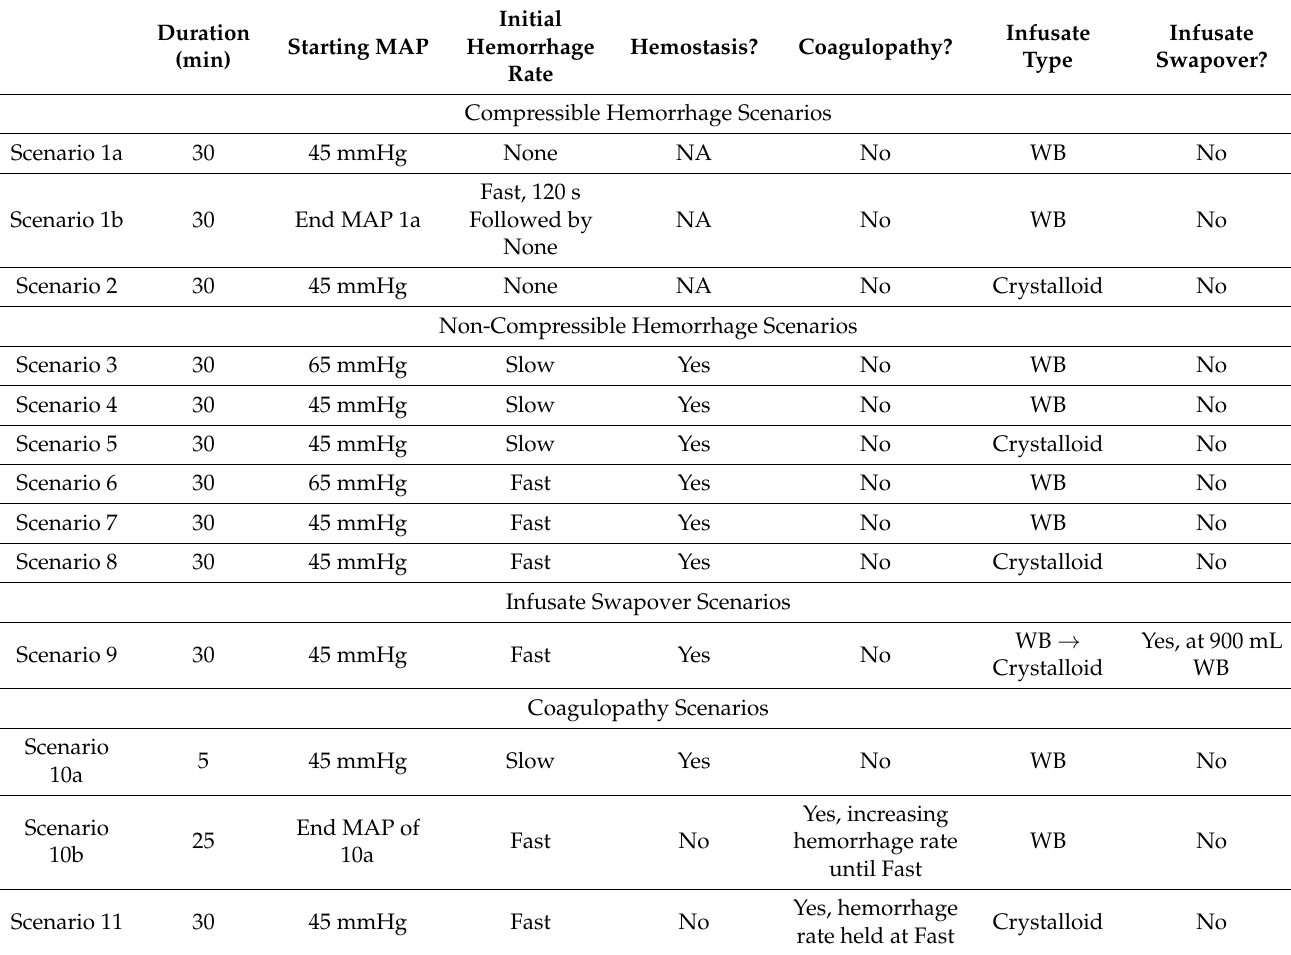
Table 1. Summary of hemorrhage scenarios used for evaluating PID controllers in